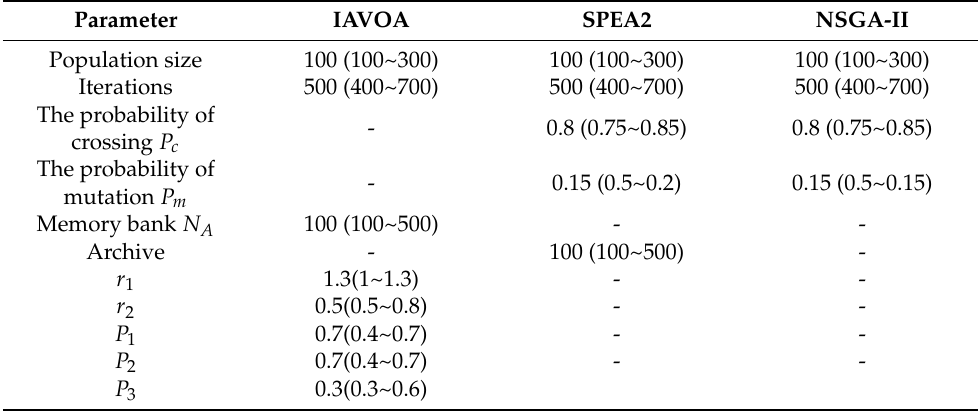
Table 5. Parameter setting values of the different